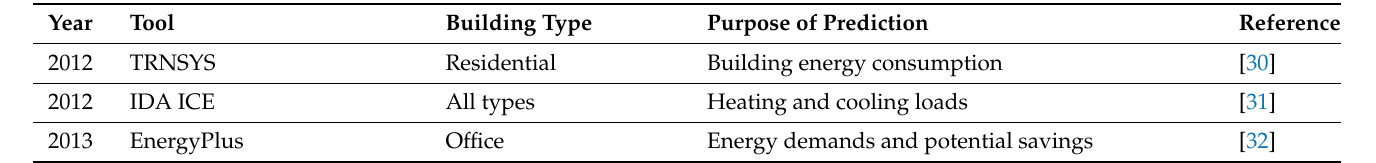
Table 1. Studies related to white-box building energy prediction